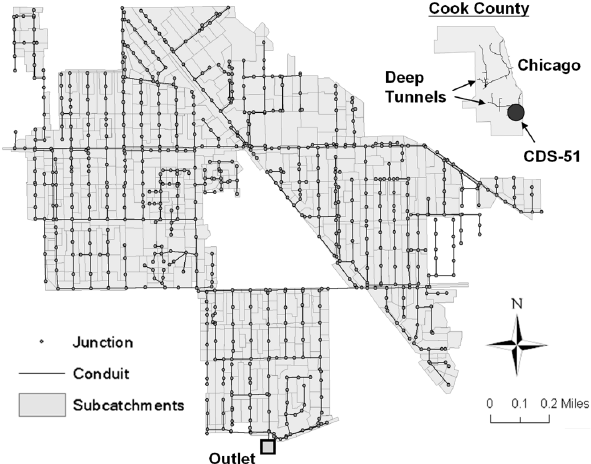
Fig. 2. The drainage pipe network; CDS-51 in